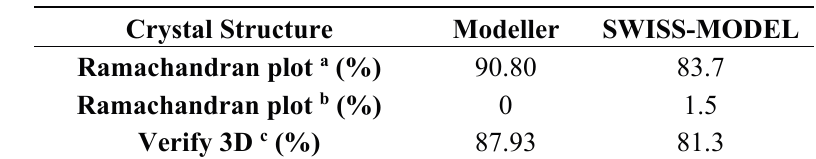
Table 2. Results of validation step Procheck and Verify 3D for the two models constructed by using Modeller and SWISS-MODEL programs compared to two models obtained from the